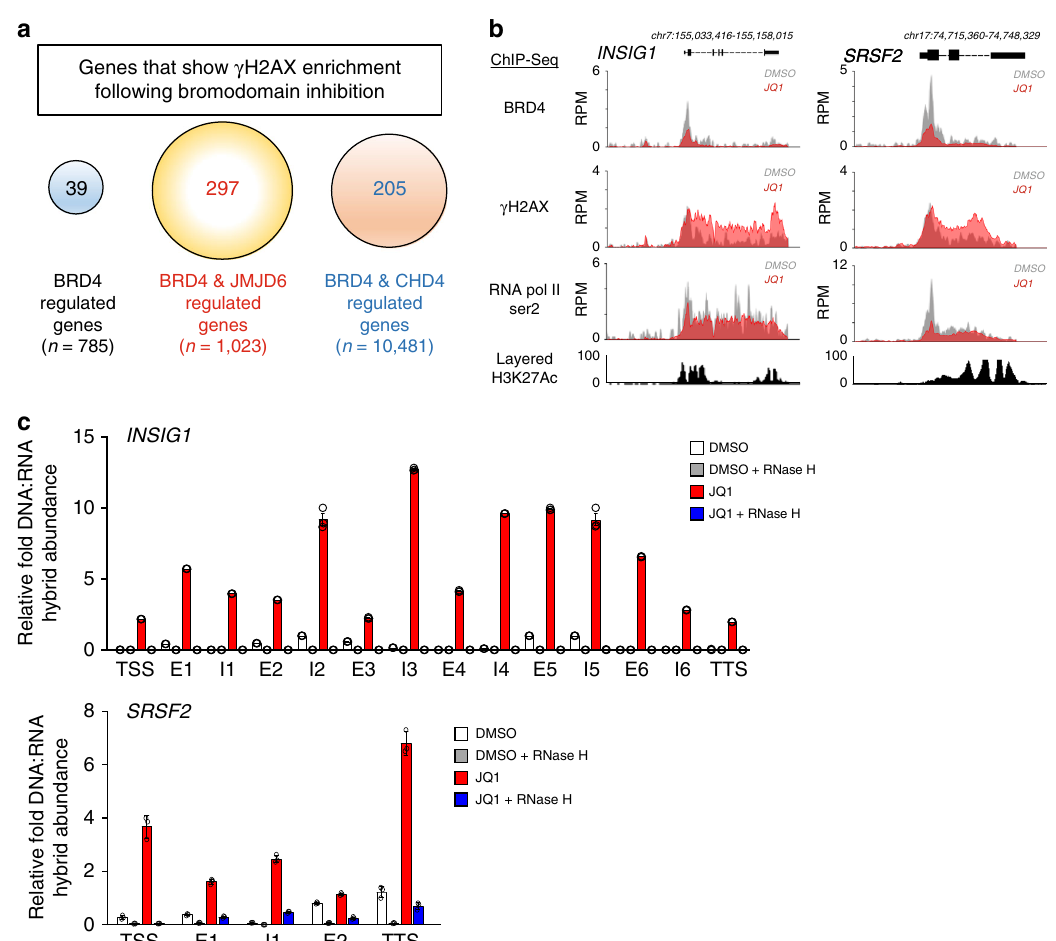
Fig. 7 BRD4 loss induces R-loops and DNA damage at a subset of genes. a Diagram showing a subset of BRD4, JMJD6, and CHD4 co-regulated loci that show enrichment of γ H2AX using ChIP-Seq following treatment with 500 nM JQ1 for 16 h. b BRD4, γ H2AX, and RNAPII ser2 ChIP-Seq plots at the INSIG1 and SRSF2 loci following treatment with DMSO (gray) or 500 nM JQ1 for 16 h (red). In this and subsequent ChIP-Seq fi gures, layered H3K27Ac ChIP-Seq plots from ENCODE signify actively transcribed loci. c Quanti fi cation of relative abundance of DNA:RNA hybrids spanning the INSIG1 and SRSF2 loci following treatment with DMSO (white bars), DMSO + RNase H1 (gray bars), JQ1 (red bars), JQ1 + RNase H1 (blue bars) using DRIP-qPCR (TSS = transcription start site, E = exon, I = intron). Data presented as mean ± SEM ( n = 3 separate experiments). Source data are provided as a Source data fi